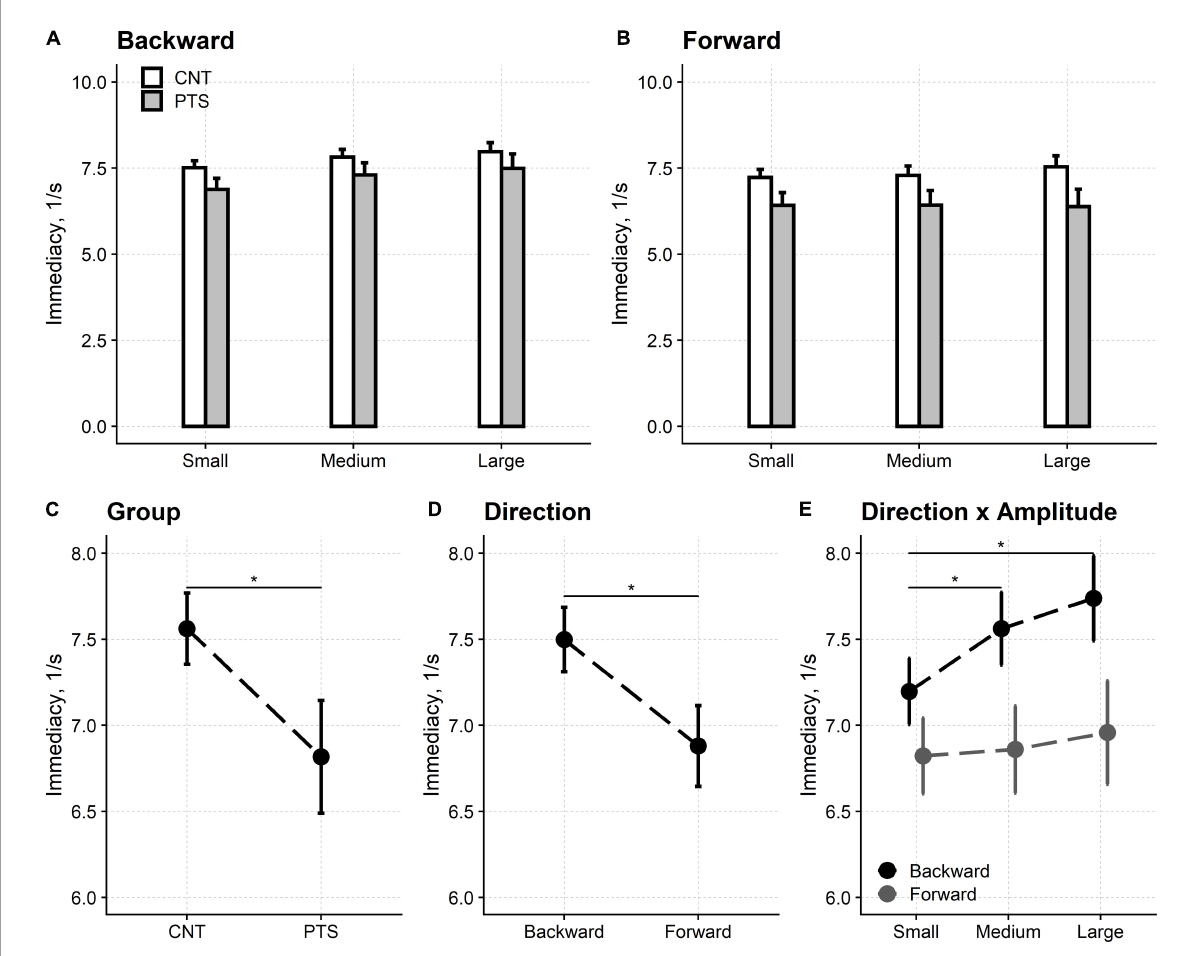
FIGURE3 Motor control test. Upper row: the immediacy of the reflexes elicited by backward (A) and forward (B) platforms’ displacements. Lower row: main effects and interaction from the regression model. The immediacy of the force reflexes is shown for the two groups of participants [ (C) Group] and the two directions of the platforms’ shifts [ (D) Direction]. The amplitude of the perturbation also affected the reflexes’ immediacy. However, this is not shown because the interaction between direction and amplitude [ (E) Direction × Amplitude] showed that the perturbation’s amplitude only affected the immediacy of the reflexes evoked by backward shifts. CNT, controls; PTS, patients. Mean and 95% confidence interval are plotted; ∗ Significant difference at p < 0.05. The difference between the reflexes’ immediacy evoked by backward and forward shifts is significant for each of the three perturbations’ amplitudes (not marked with * for graphical